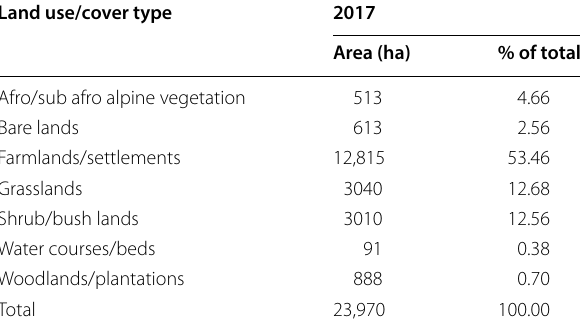
Table 2 Area cover of the land use/cover classes of the watershed at different periods of time Land use/cover type